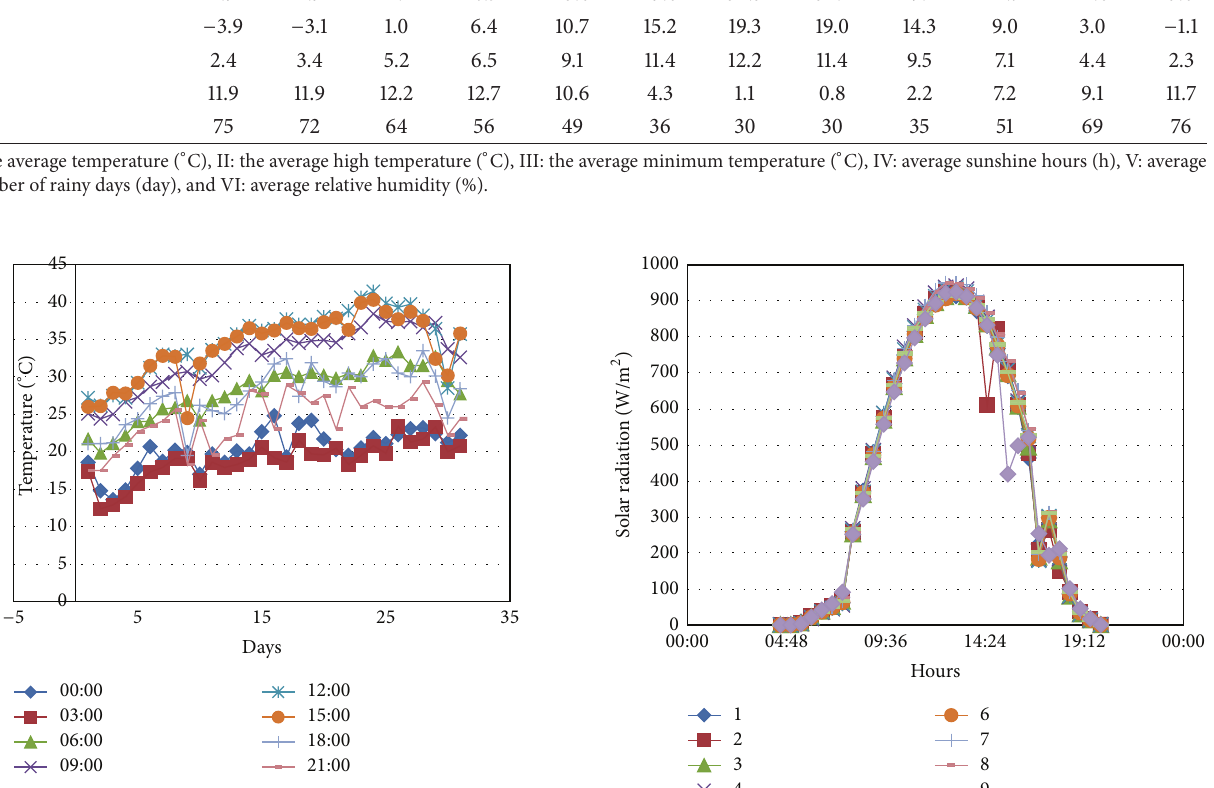
Figure 2: Hourly average outdoor air temperatures in the month of July.